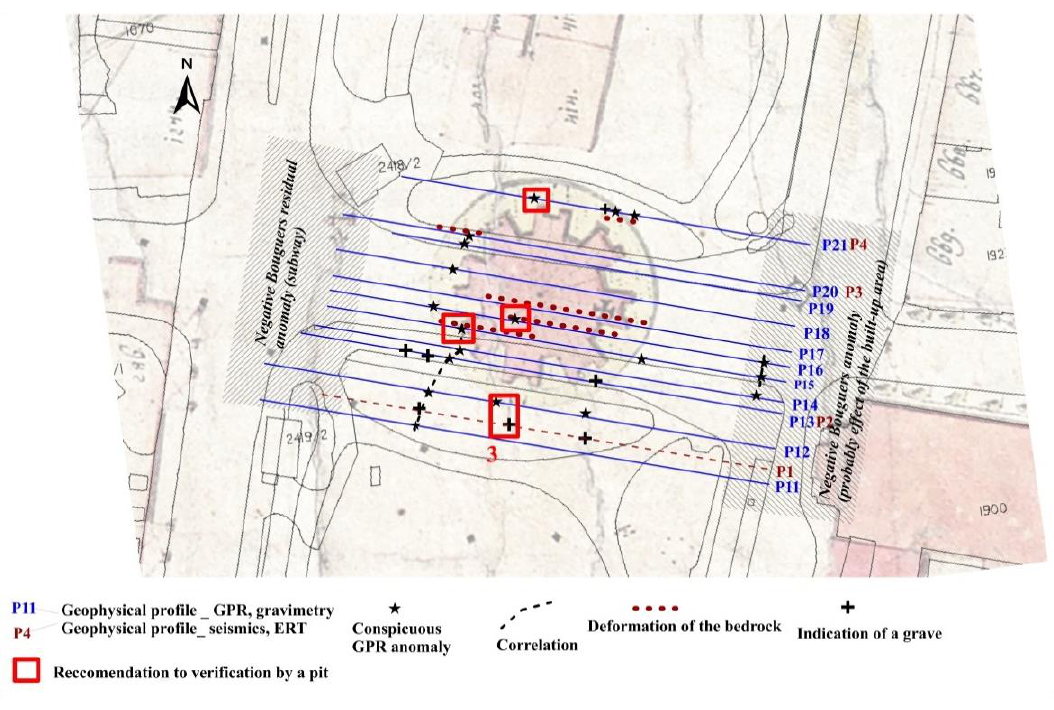
Figure 16. Charles Square. The archival map with the foundation of the chapel (Helgert, 19th Century) with principal geophysical anomalies indicating single graves or tombs. Archaeological test pits are marked in red.